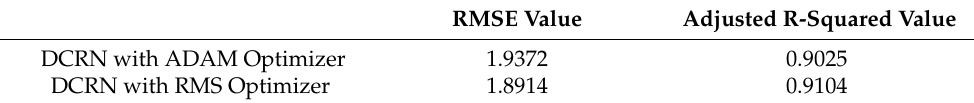
Table 4. The RMSE values for DCRN approach with SG Layer based on different